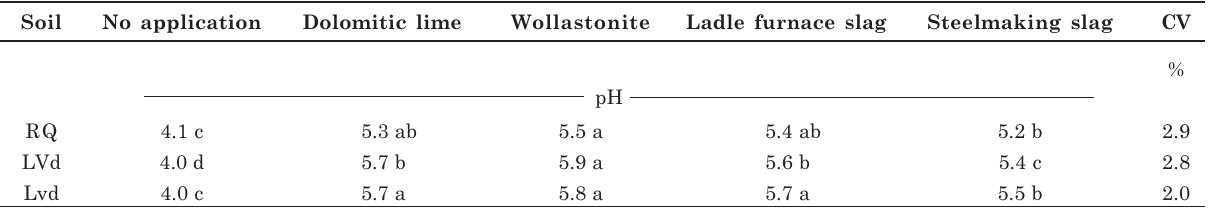
Lvd: dystroferric Rhodic Hapludox (Oxisols); LVd: dystrophic Rhodic Hapludox (Oxisols); RQ: dystrophic Typic Quartzipsamment (Entisol). Means followed by lower-case letters in the same row differ statistically by Tukey’s test at 1 %.